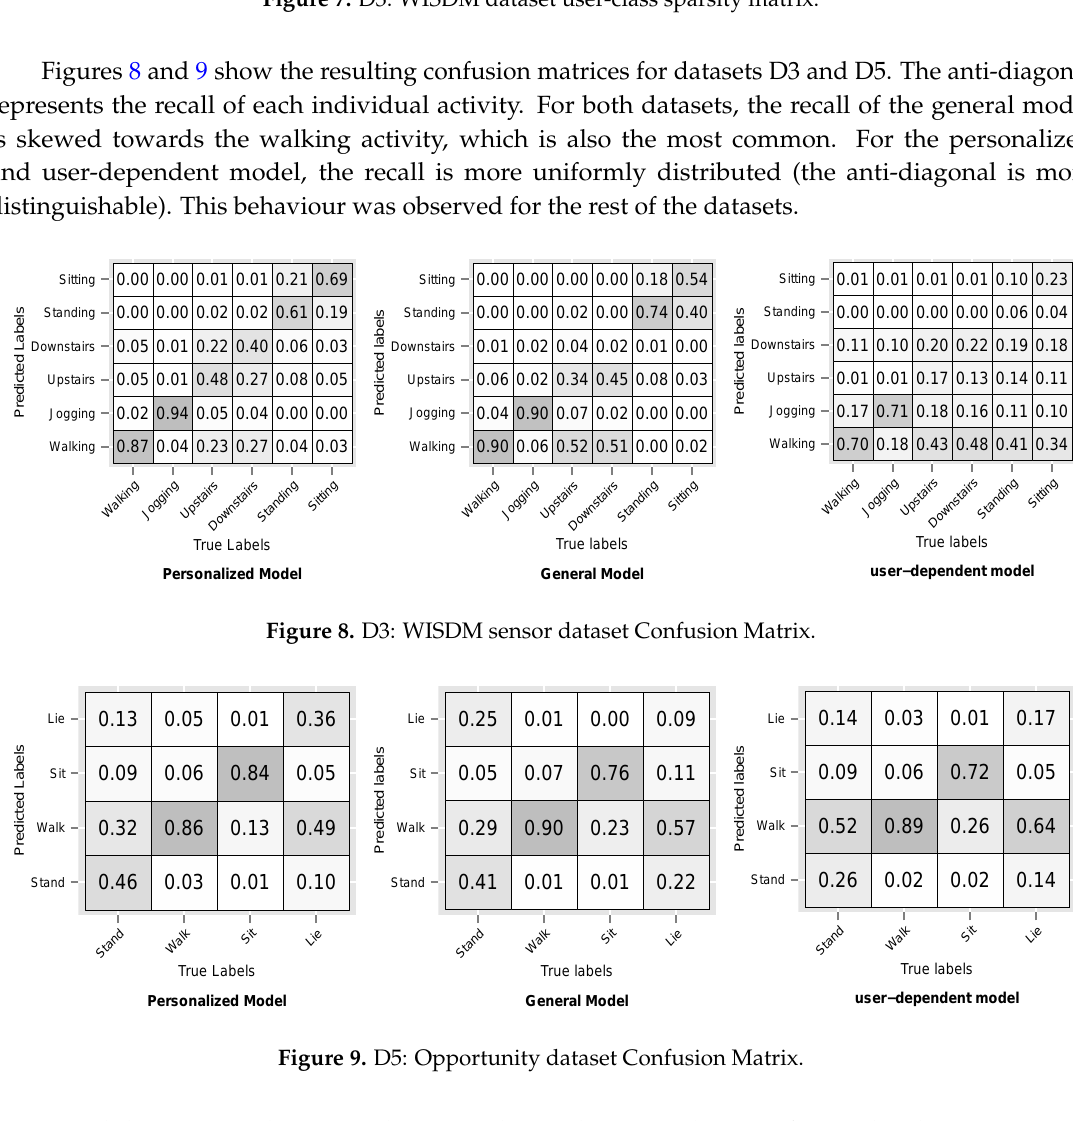
Figure 7. D3: WISDM dataset user-class sparsity matrix.